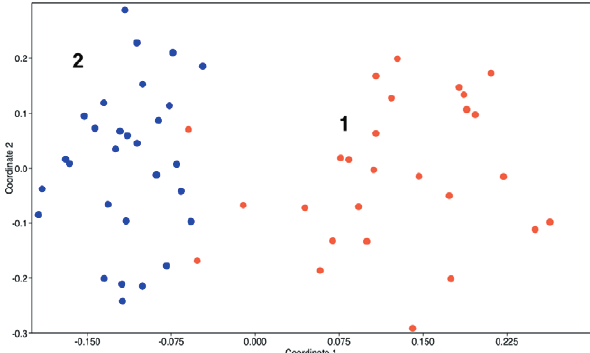
Figure 3. MDS plot of selected rice